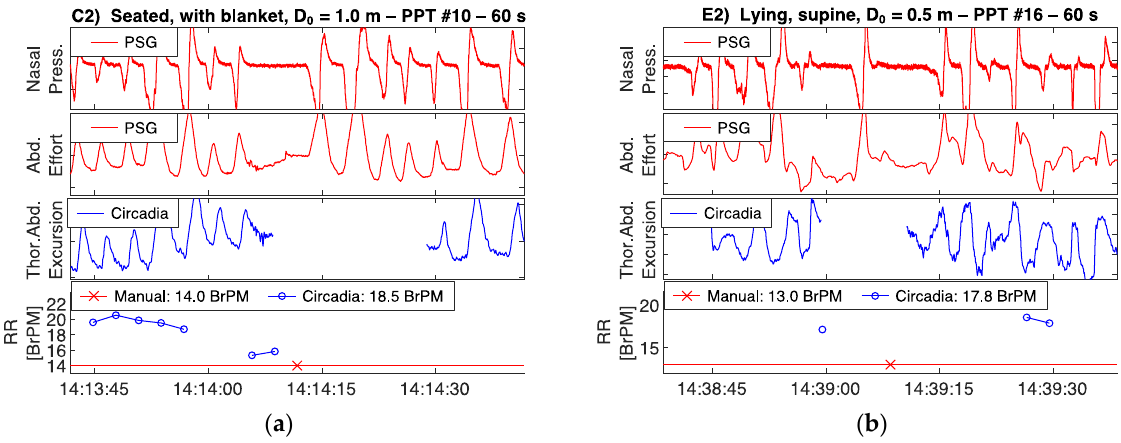
Figure 6. Circadia respiratory thoracoabdominal excursion (blue), and reference nasal pressure and abdominal effort (red) for two example epochs from Study 1. Circadia continuous respiratory rate (RR; blue) and manually scored RR based on reference data (red) are shown in the bottom graph, with final RR values of both methods in the legend of the bottom graph.